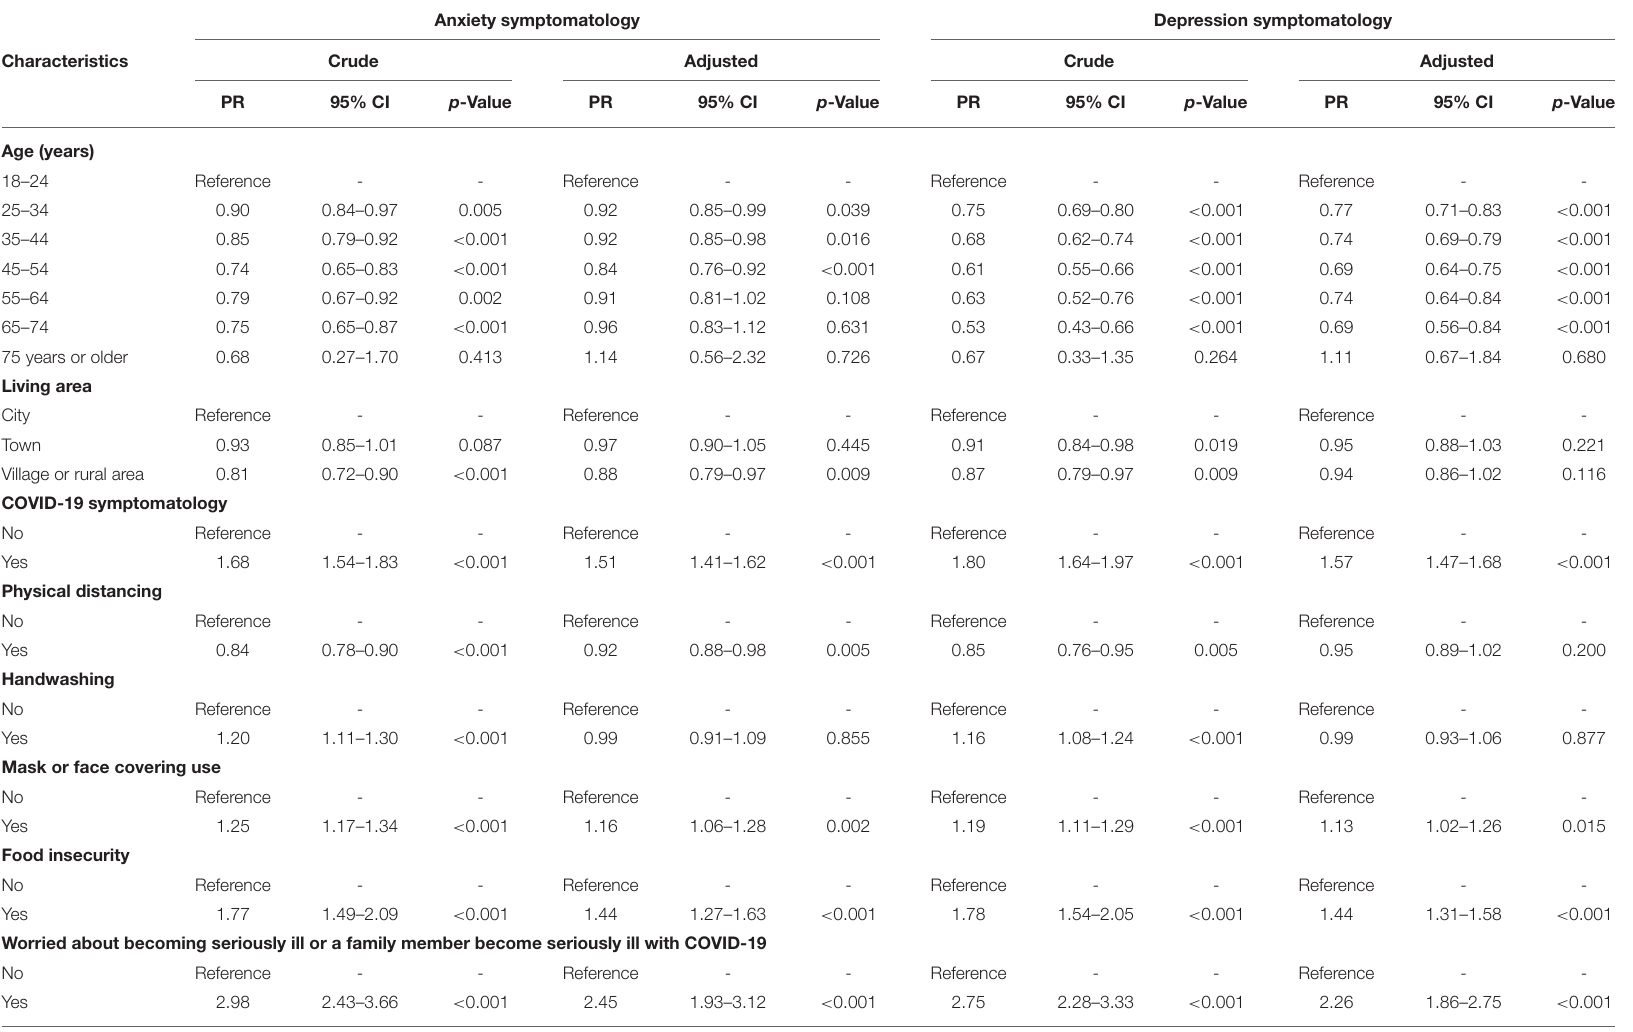
TABLE 6 | Crude and adjusted generalized linear models of Poisson family with logarithmic link to evaluate the factors associated with anxiety or depression in non-binary